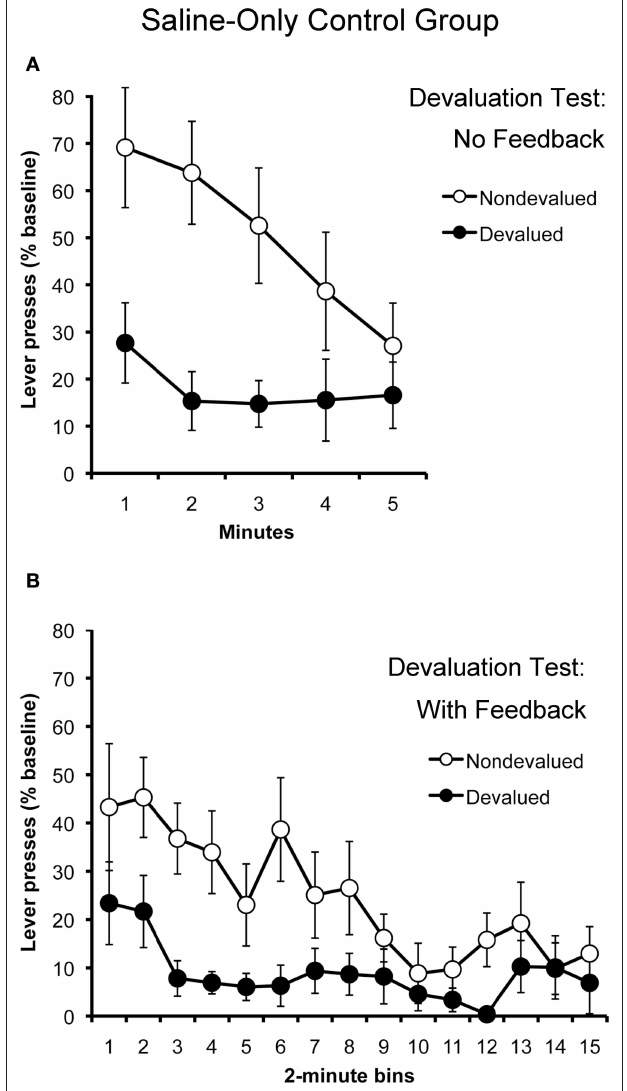
FIgure 4 | Outcome devaluation performance in saline-only treated rats (experiment 2). Mean rate of lever pressing (percentage of baseline, ± SEM) for the devalued and non-devalued outcomes in extinction (A) and rewarded (B)